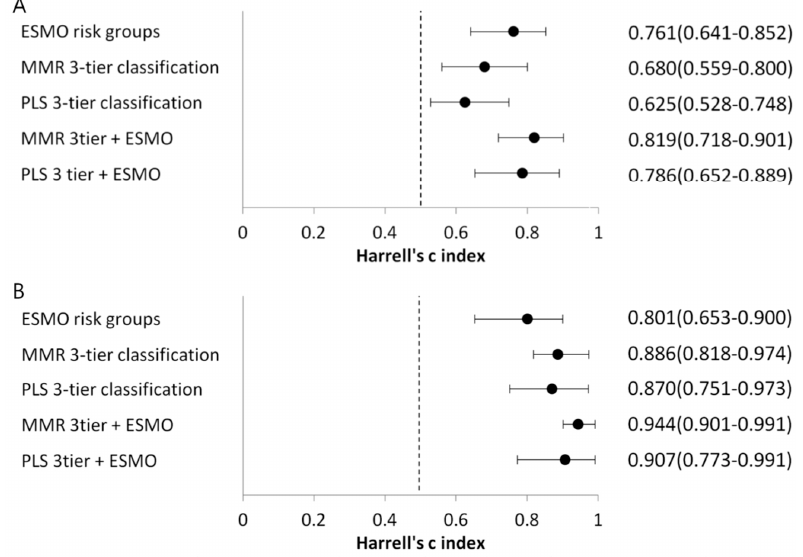
Figure 4. Kaplan–Meier curves for progression-free survival (PFS) ( A ) and overall survival (OS) ( B ), according to the practical molecular classification of endometrial cancer, based on DNA mismatch repair (MMR) status and p53 staining results in endometrial cancer patients. Kaplan–Meier curves for progression-free survival (PFS) ( C ) and overall survival (OS) ( D ), according to the practical molecular classification of endometrial cancer based on probable Lynch syndrome (PLS) status and p53 staining results in endometrial cancer patients.